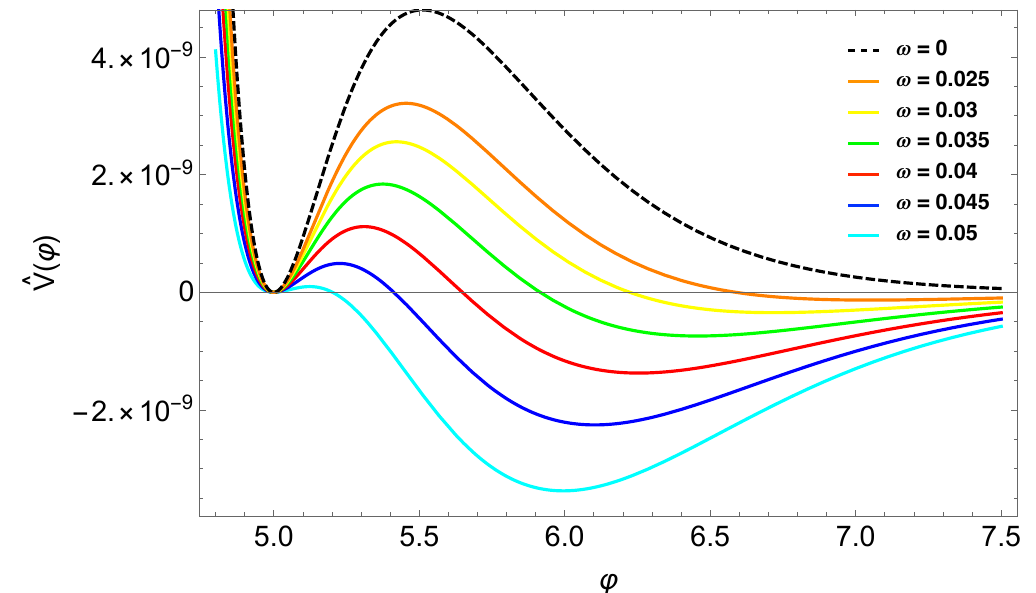
Figure 5 . Modi(cid:12)ed potential ^ V for di(cid:11)erent values of the constant !